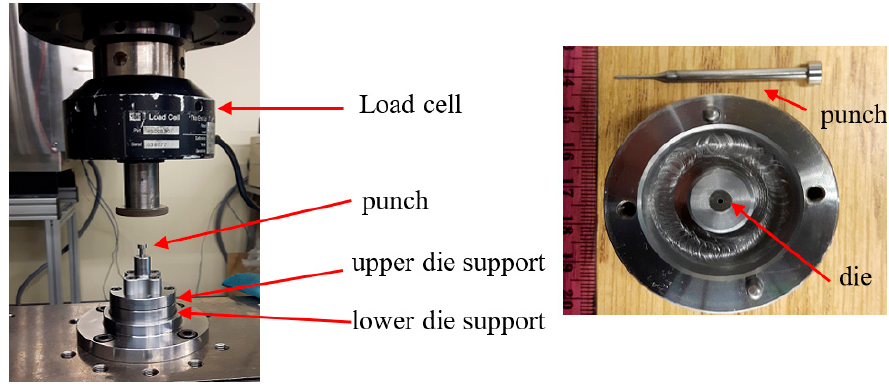
Figure 2. Shear punch test set-up.